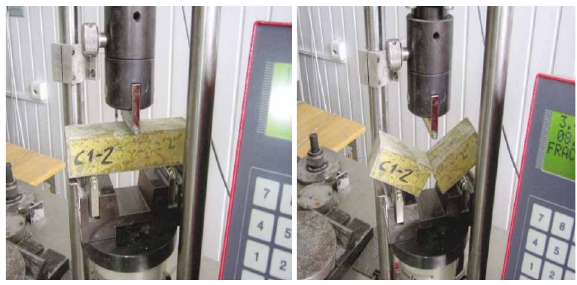
Fig. 2. A test on bending strength